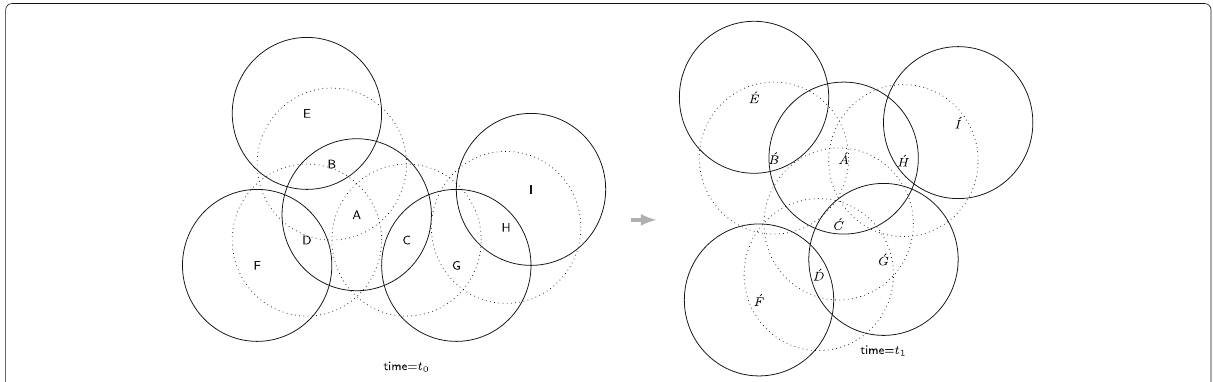
Fig. 15 Network configurations at two time instances while the nodes are moving